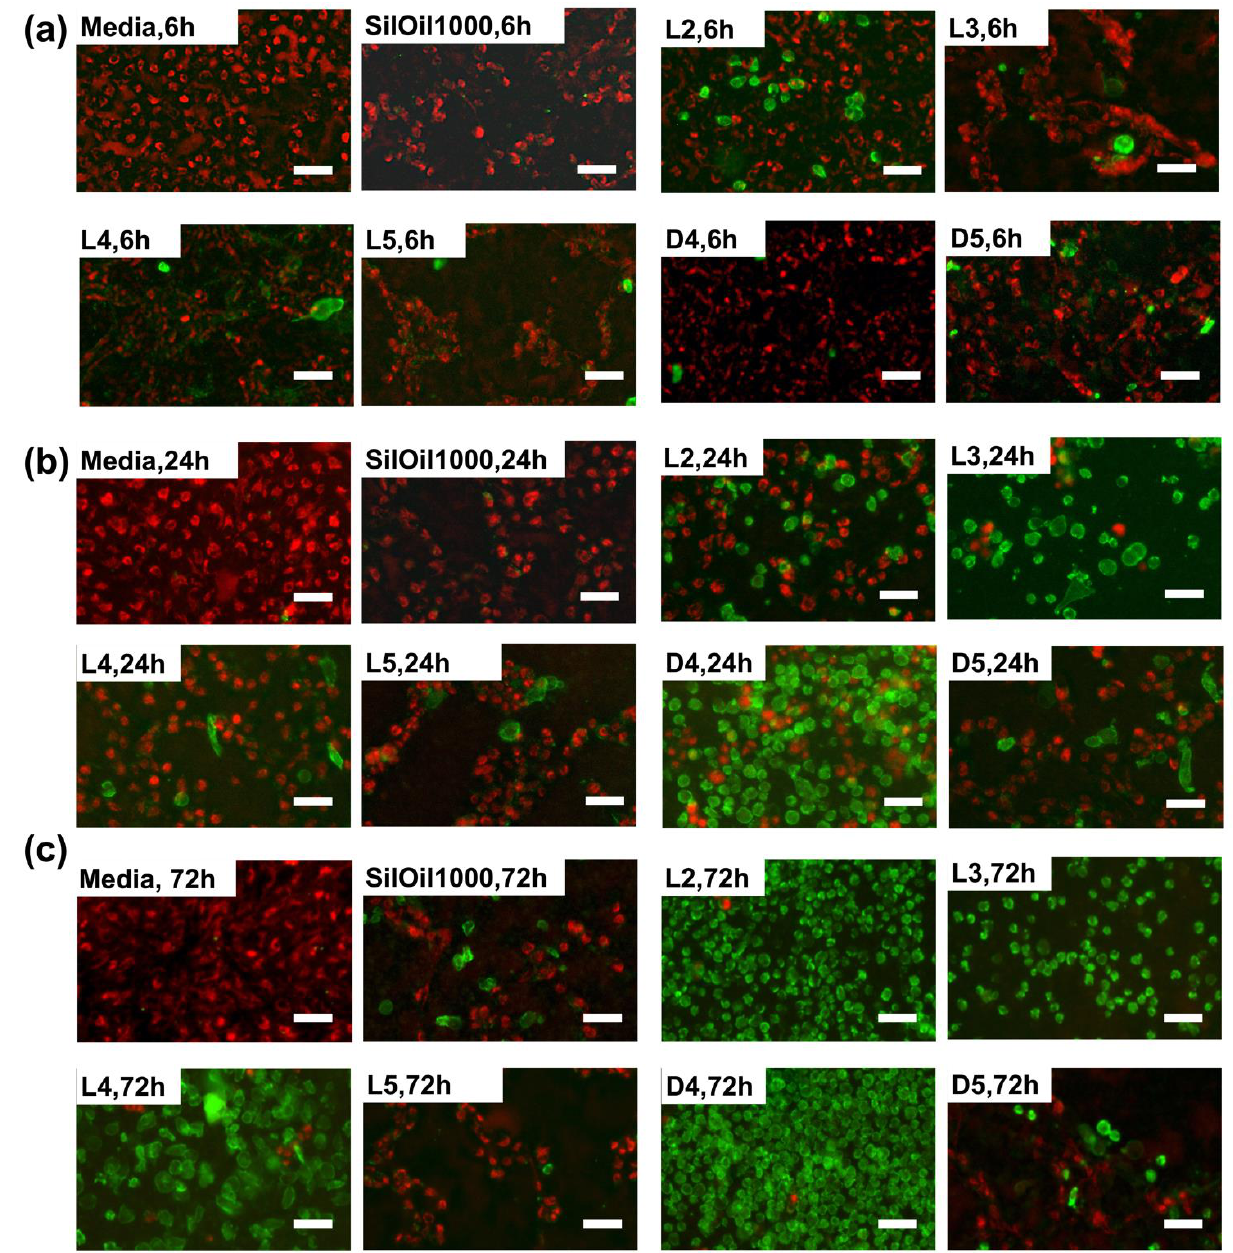
Figure 7. Fluorescent microscopic images of the ARPE-19 cells after incubating with emulsified LMWCs and control groups at ( a ) 6 h, ( b ) 24 h and ( c ) 72 h. Cells in red and green represent living and dead cells, respectively. The results in ( a – c ) are representative of those from 1 independent experiment with 2 replicates each.